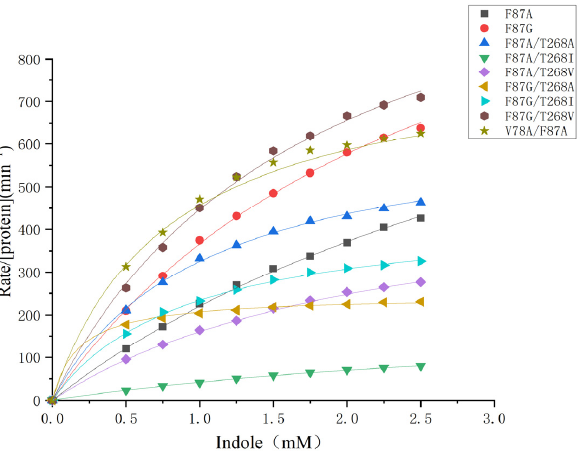
Figure 5. The plots of catalytic reaction rate of the indole formation by a series of P450BM3 mutants against the concentration of indole. Table 1. Kinetic parameters of P450BM3 and its mutants, Mb and Ngb, catalyzed indole oxidation.